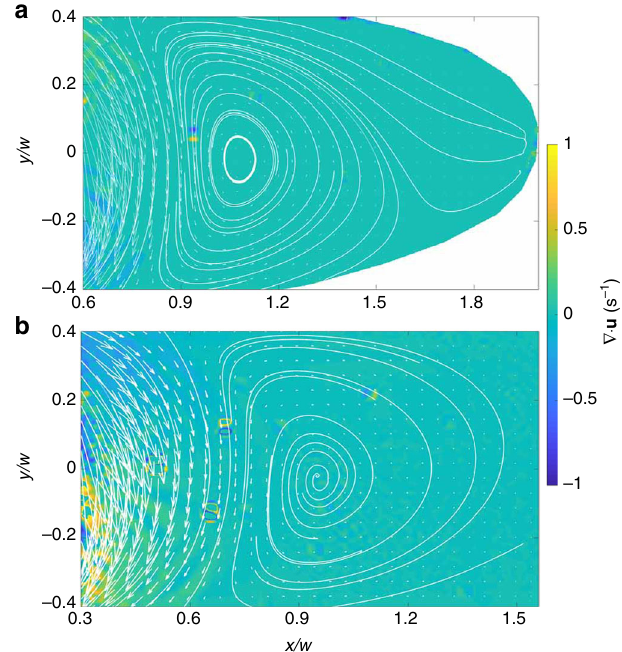
Fig. 6 Divergence of the velocity fi eld obtained from experiments. Divergence fi eld (in color) obtained from measured velocity fi eld (shown by arrows) for a elliptical cavity of e = 0.97 and b rectangular cavity. Streamlines are shown by the white lines. Other velocity fi elds ( e = 0.9 and 0.95) also show zero average divergence (see Supplementary Figure